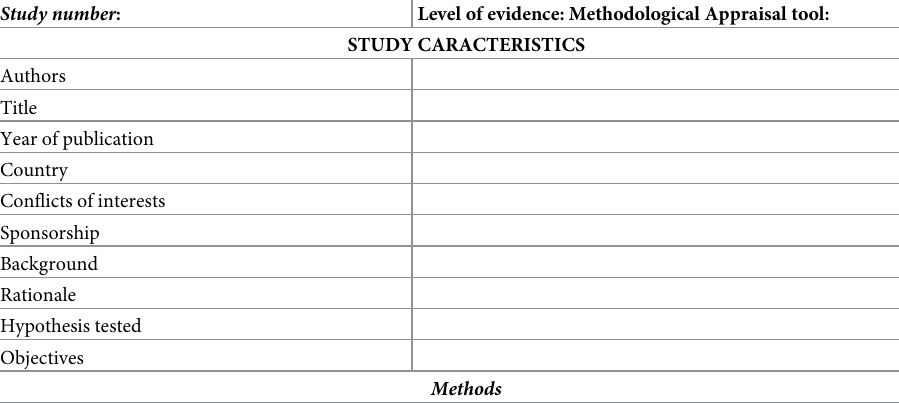
Table 2. Data extraction form based on previous publications [17, 20,